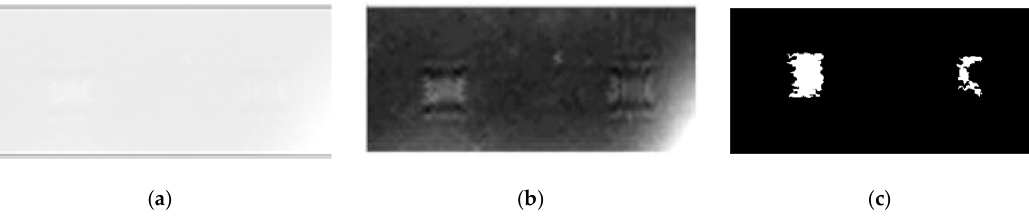
Figure A1. Images of notch 1 under the 2 mm-thick rubber layer obtained at a standoff distance of 0.25 mm: ( a ) original, and after ( b ) average filtering and ( c ) thresholding by the developed fuzzy c-mean thresholding algorithm.